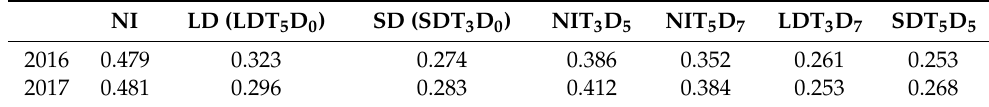
Table 3. The irrigation volume of treatment/m 3.